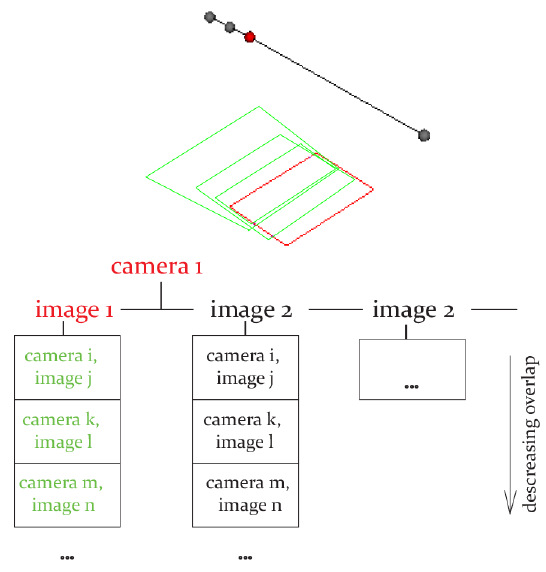
Figure 3: Up: result of a partial search on camera1 image1 (red), linked footprints are displayed in purple; down: the same but contained in a data